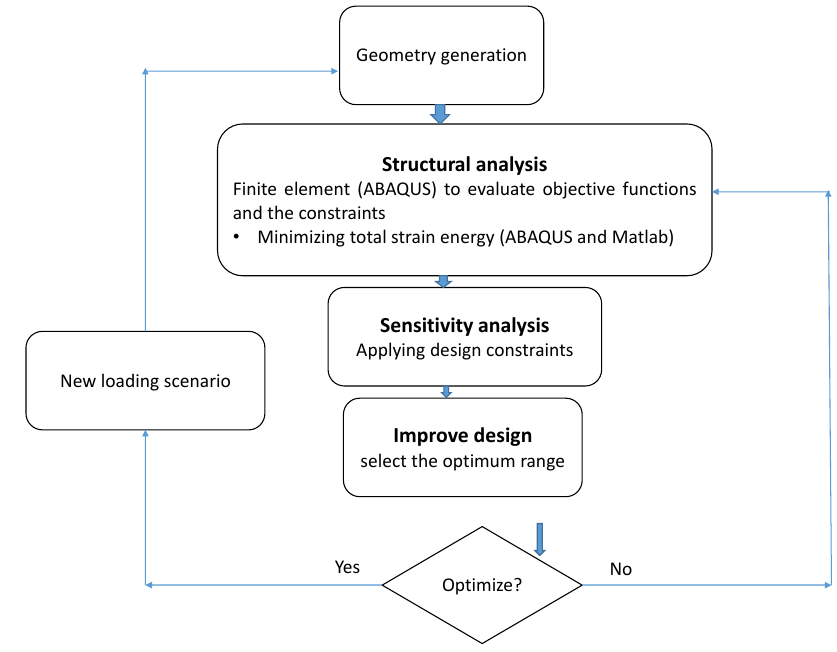
Figure 6. Optimization process for shape optimization of steel dampers.